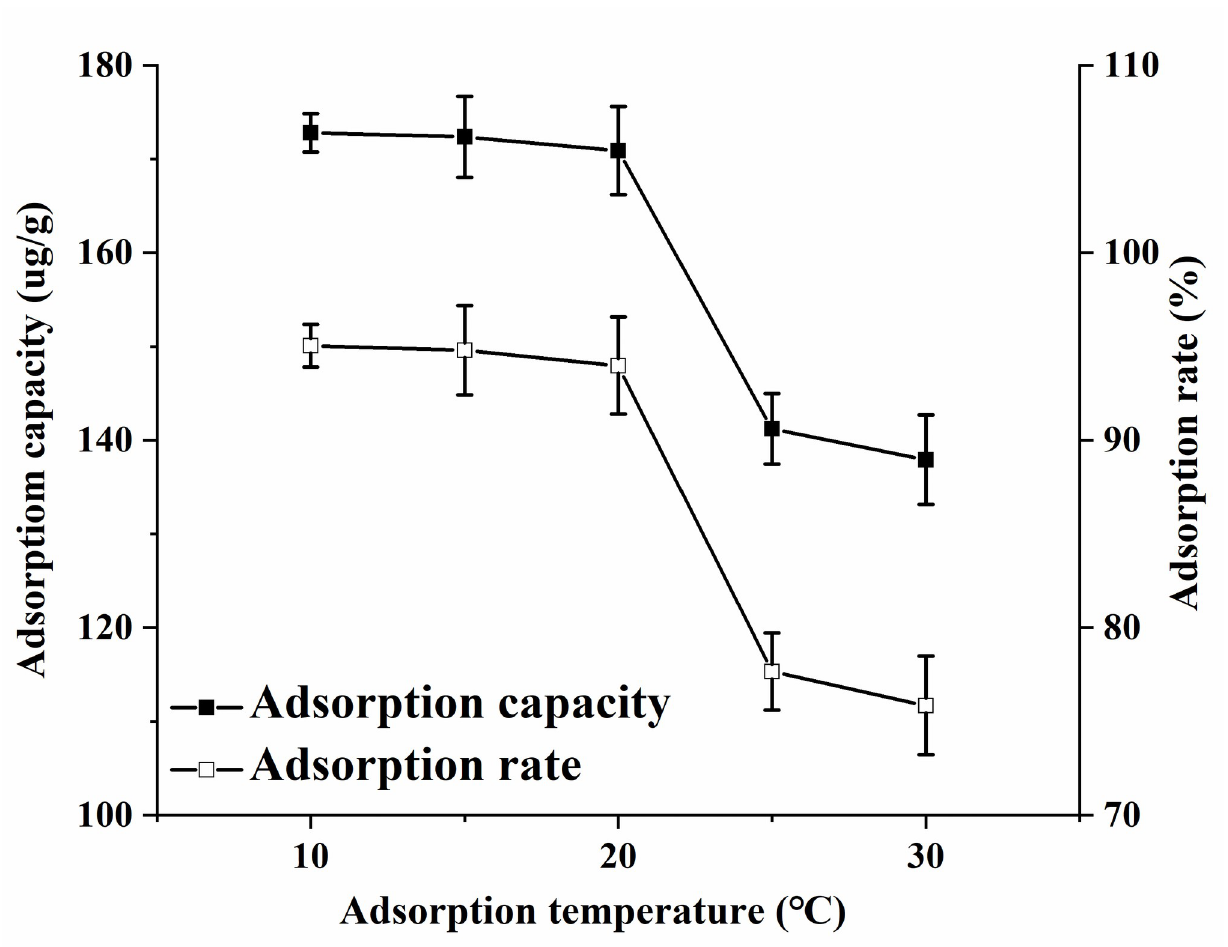
Fig 6. Effect of temperature on the adsorption of MMS to